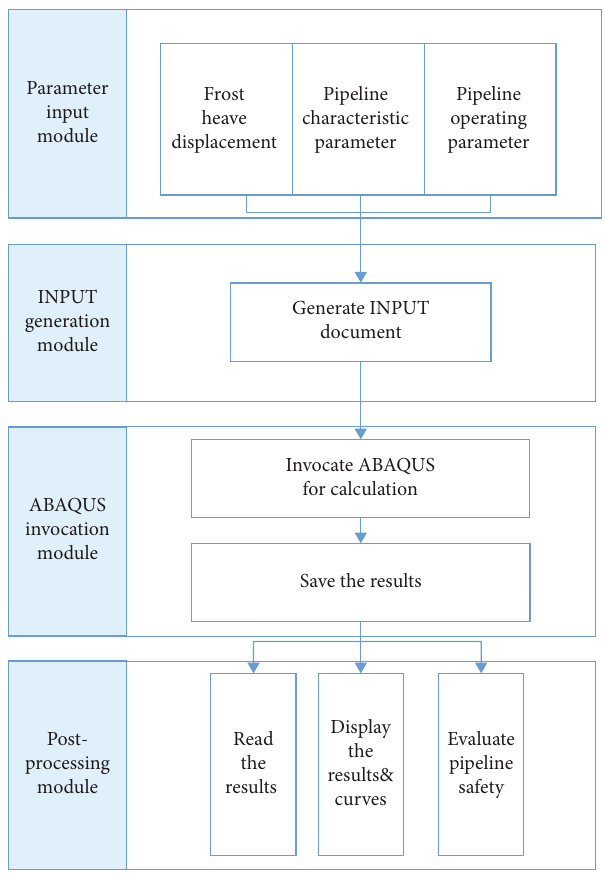
Figure 8: Overall architecture of a customized parametric strain calculation software developed based on